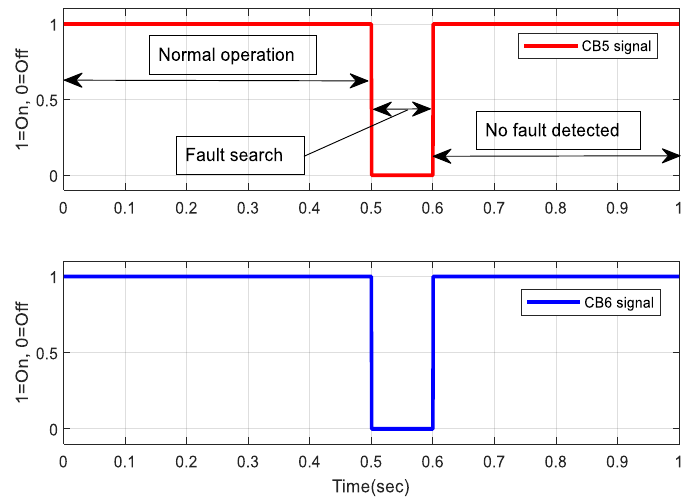
Figure 9. The CB5 and CB6 of the MG under normal operation, fault searching, and no-fault detected at